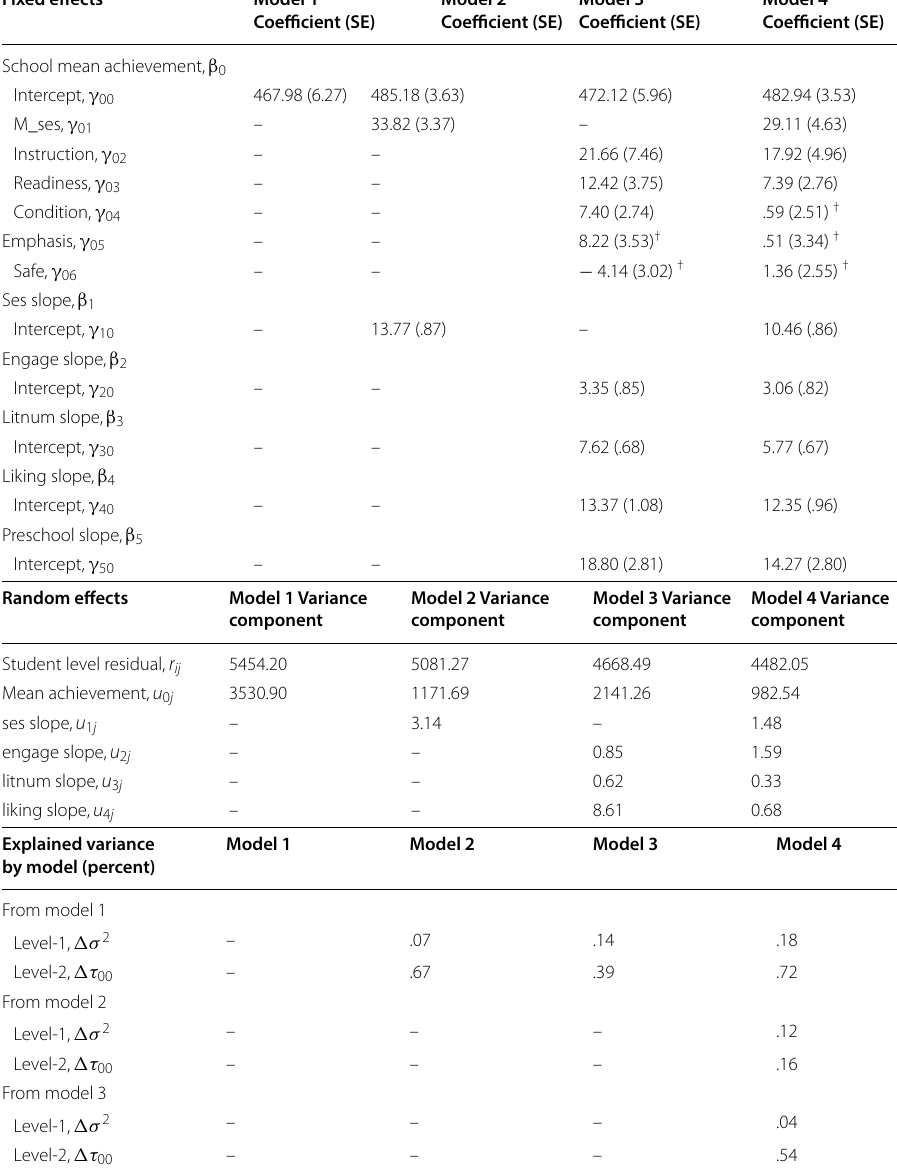
All fixed-effects coefficients were significant at the alpha level of .01, except